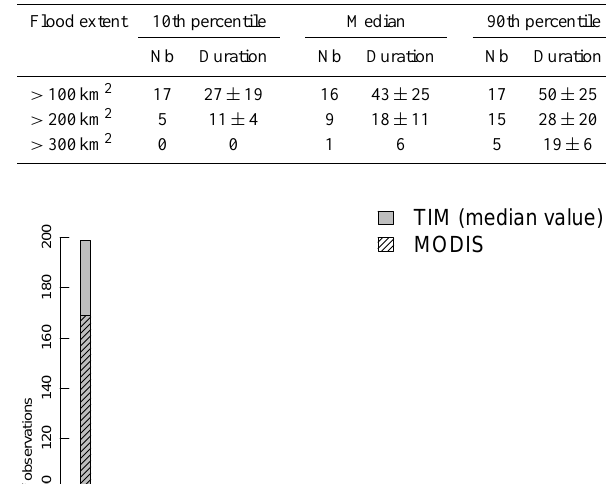
Table 9. Annual water flows (km 3 yr − 1 ), calculated from the me- dian values of